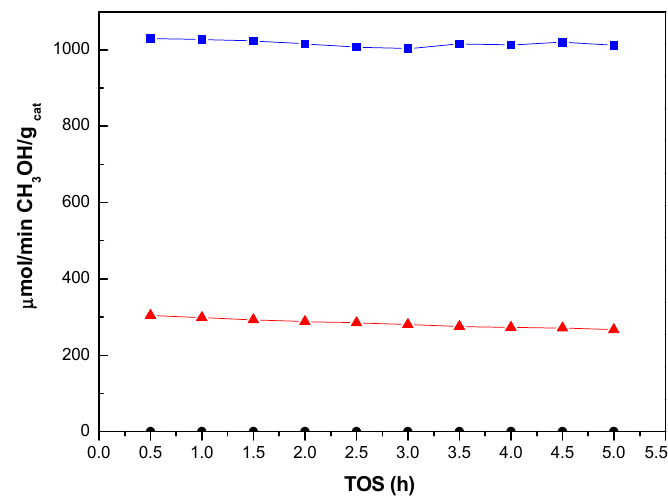
Figure 8. Activity measurements in methanol synthesis from syngas vs. time on stream (TOS) (250 °C, P = 3 MPa, GHSV (gas hourly space velocity) = 32,700 h − 1 ) over: ( ● ) Cu/ZnO-Al-W/O, ( ▲ ) Cu/ZnO-Al-W1, ( ■ ) Cu/ZnO-Al-W3.